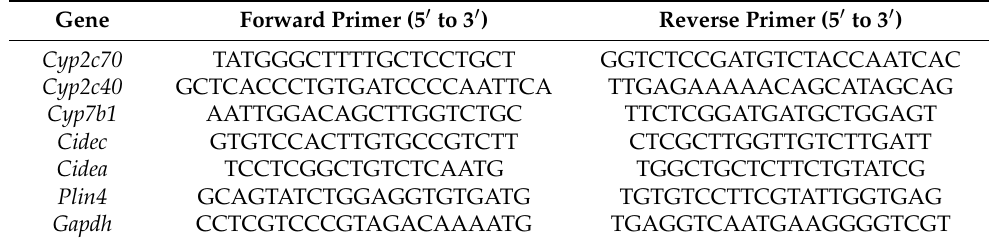
Table 1. Primers of